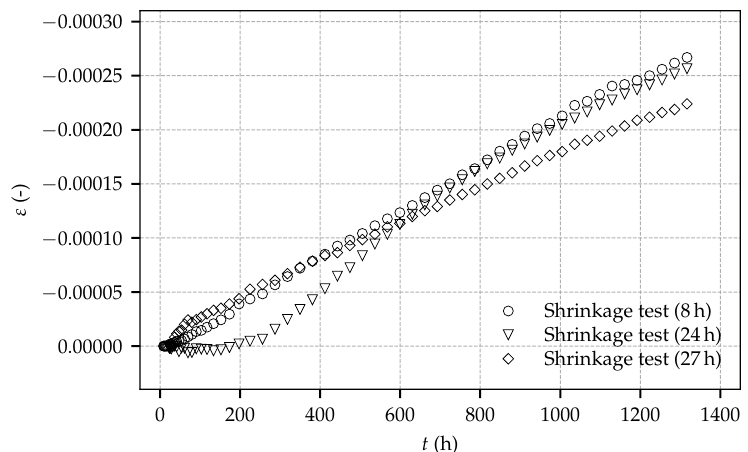
Figure 6. Evolution of the total strain determined on sealed, load-free specimens: experimental results for the tests on three specimens of the present experimental program, started at shotcrete ages of 8 h, 24 h and 27 h.